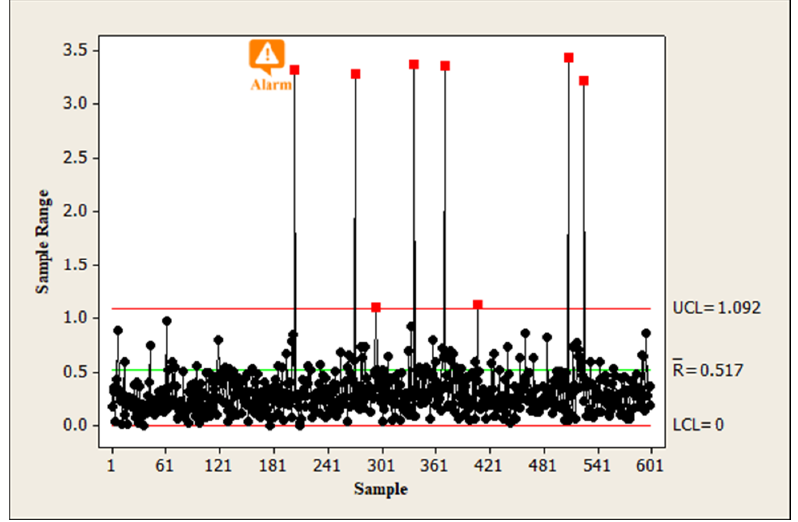
Figure 14. R-control chart of the recursive CUSUM decision function (subgroup size = 5). As depicted in Figure 13 (upper chart), during the state change occurrence, the CUSUM of the log-likelihood ratio ( (cid:1859)((cid:1863)) ) start increasing. Larger efficiency degradation indicates a higher slope. On the other hand, it can be seen in Figure 13 (lower chart) and Figure 14 that eight points are located in the out-of-control region (out of the upper control limit—UCL); these points represent the stopping alarms detected using the CUSUM. The first stopping alarm is triggered when the first state change is detected using the CUSUM; the other alarms indicate the continuous degradation in the gearbox efficiency as the slope increases, as shown in Figure 13 (upper chart). The threshold ℎ was selected to avoid false alarms. However, a change detection time delay (cid:1830) might occur accordingly, as seen in Equation (18). Thus, there is a trade-off be- tween the false alarms and the detection time. (cid:1830) = k (cid:2911) − (cid:1863) (18) Table 9 below summarises the performance monitoring results of the evaluated ANN power residuals for the three operating modes based on the gearbox efficiency degrada- tion. Table 9. Parameters description and performance monitoring results based on CUSUM algorithm. Parameter